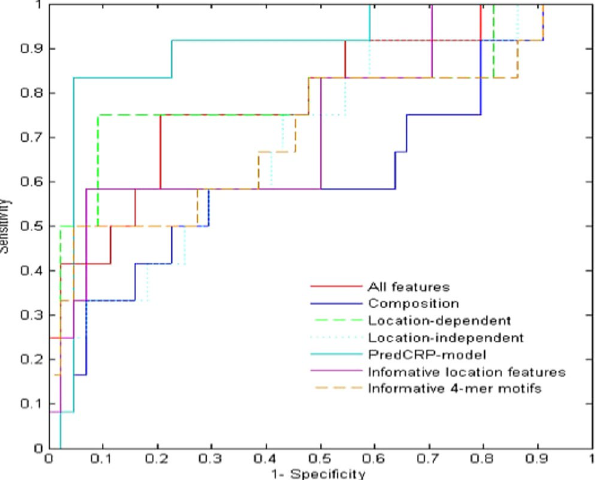
Figure 2. ROC curves of various methods using the CRPS-TST dataset. The AUCs of PredCRP-model and SVMs with informative 4-mer motifs, informative location features, all features, composition feature, location-dependent feature, and location-independent feature were 0.71, 0.73, 0.90, 0.79, 0.61, 0.79, and 0.70,